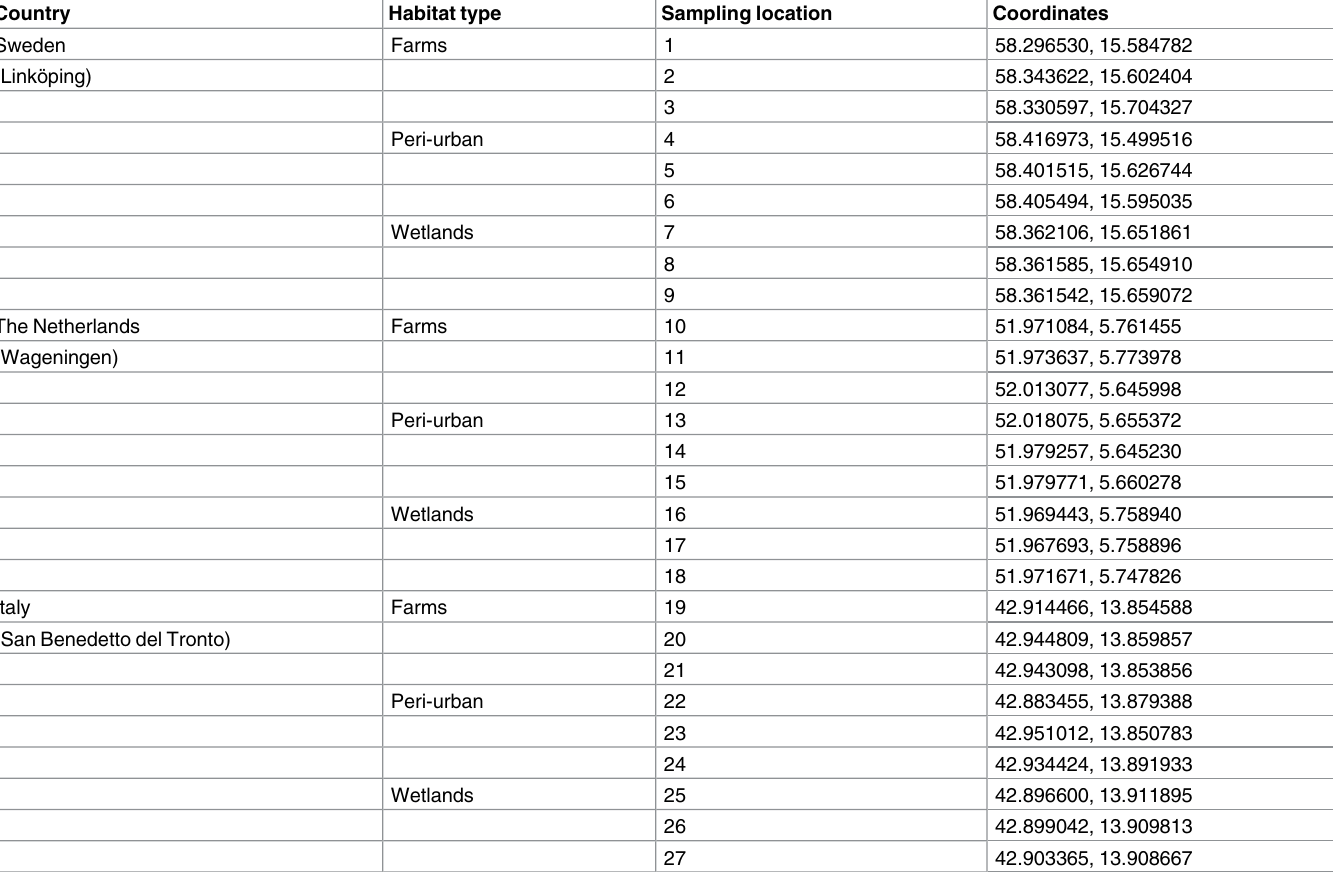
Table 1. Coordinates of all 27 trapping locations in the three different habitat types (farms, peri-urban, and wetlands) in three different European countries (Sweden, The Netherlands, and